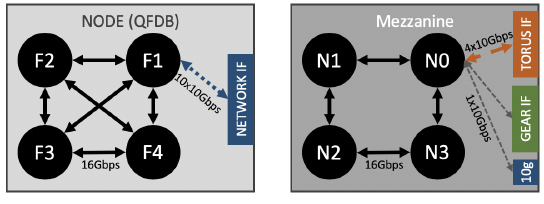
Figure 1. Testbed-1 Node and Mezzanine Topology. Four ZU9 FPGAs in an all-to-all scheme form the computing node. Four such nodes are interconnected by a ring in one mezzanine